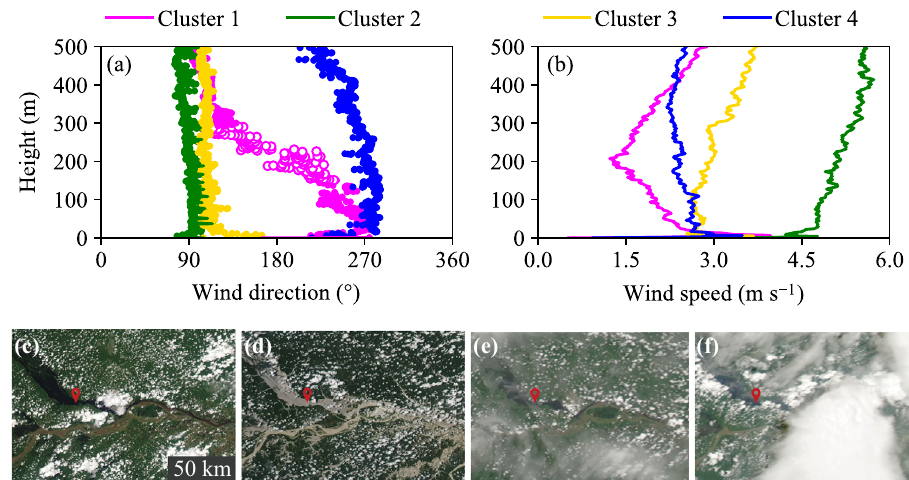
Fig. 2 Four meteorological clusters identi fi ed by analysis of 56 vertical pro fi les of data. a , b Cluster centroids of wind direction (degrees) and wind speed (m s − 1 ) from surface elevation to 500 m. Open circles indicate wind speeds slower than 2 m s − 1 , for which the wind direction was less certain. c – f Satellite images of cloud coverage that were typical of clusters 1, 2, 3, and 4, respectively 43 . Images were taken by the Aqua satellite at 13:30 (LT) on 26 September 2019, 30 September 2019, 1 October 2019, and 8 October 2019. The imaged rivers correspond to those apparent in Fig. 1c. The boat was positioned at the red marker. Satellite image credit: NASA ’ s Earth